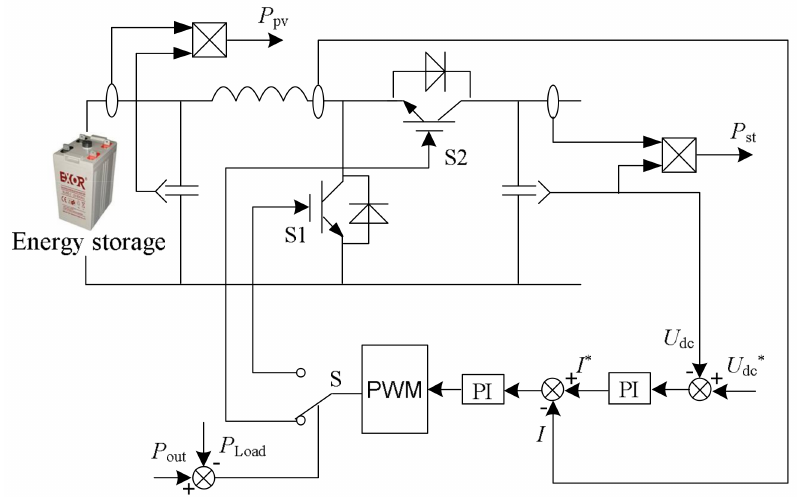
Figure 10. Structure and control of bidirectional